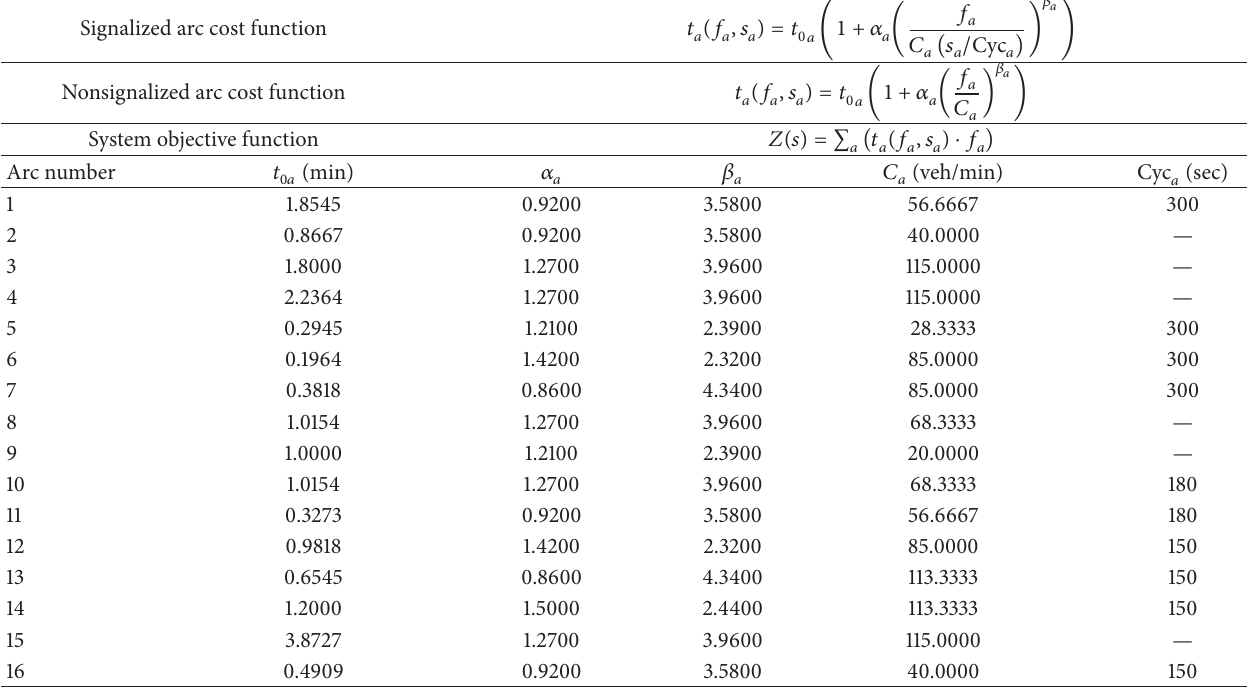
Figure 2: The network topology in Example 2. Table 3: Arc cost functions and the system objective function in Example 2.